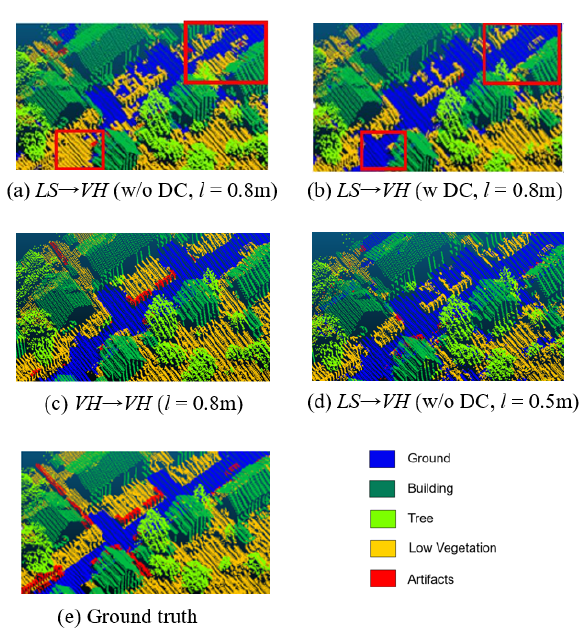
Figure 2. Example visualisation (experiment I).